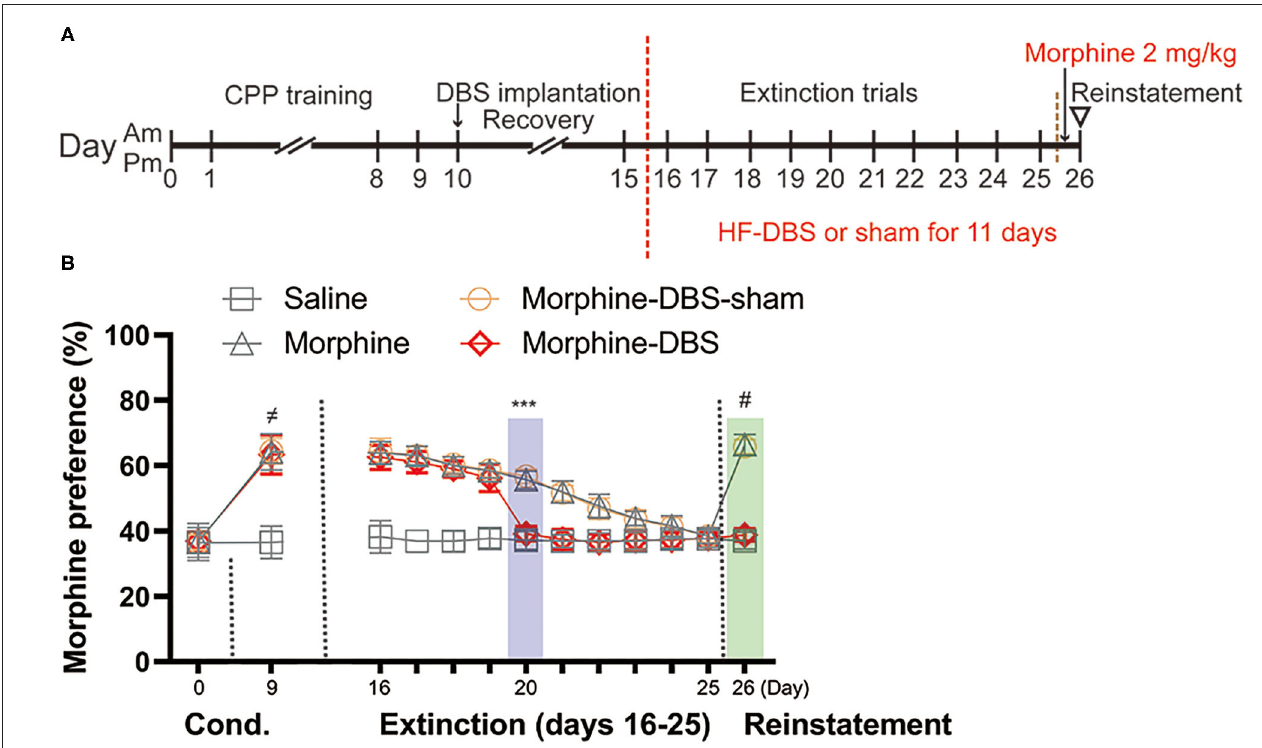
FIGURE 3 | Continuous high frequency-DBS (HF-DBS) of anterior insula (AI) accelerates extinction and prevents priming-induced relapse of morphine-induced conditioned place preference (CPP). (A) Experimental scheme. After an 8-day morphine-CPP training, the rats were bilaterally implanted with DBS electrodes to AI (morphine-DBS and morphine-DBS-sham groups) followed by a 5-day recovery. All groups of rats were further subjected to drug-free daily extinction sessions (Day 16–25). HF-DBS (130Hz, 150 µ A, 90 µ s) was continuously applied in morphine-DBS rats. Twenty-four hours after the complete extinction, all groups of rats received a priming dose of morphine (2 mg/kg) followed by a CPP test. (B) The morphine-DBS group expressed the complete extinction of morphine-induced CPP on day 20, which were 5 days earlier than both morphine and morphine-DBS-sham groups (Two-way repeated-measures ANOVA, phase: F (12, 29) = 195.486, p <